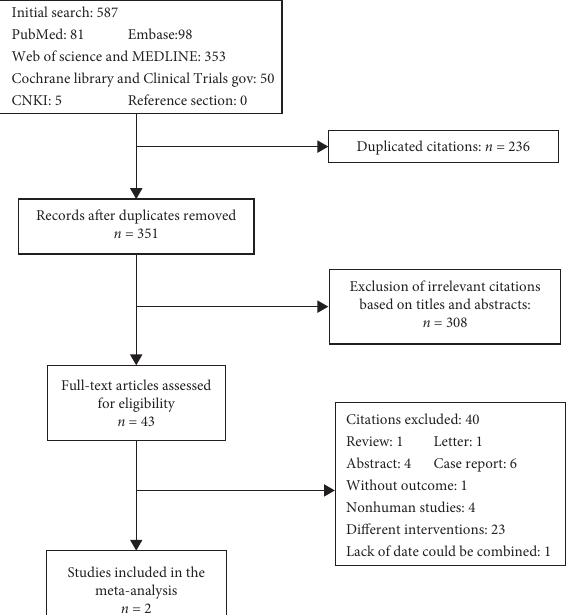
Figure 1: Flowchart of study